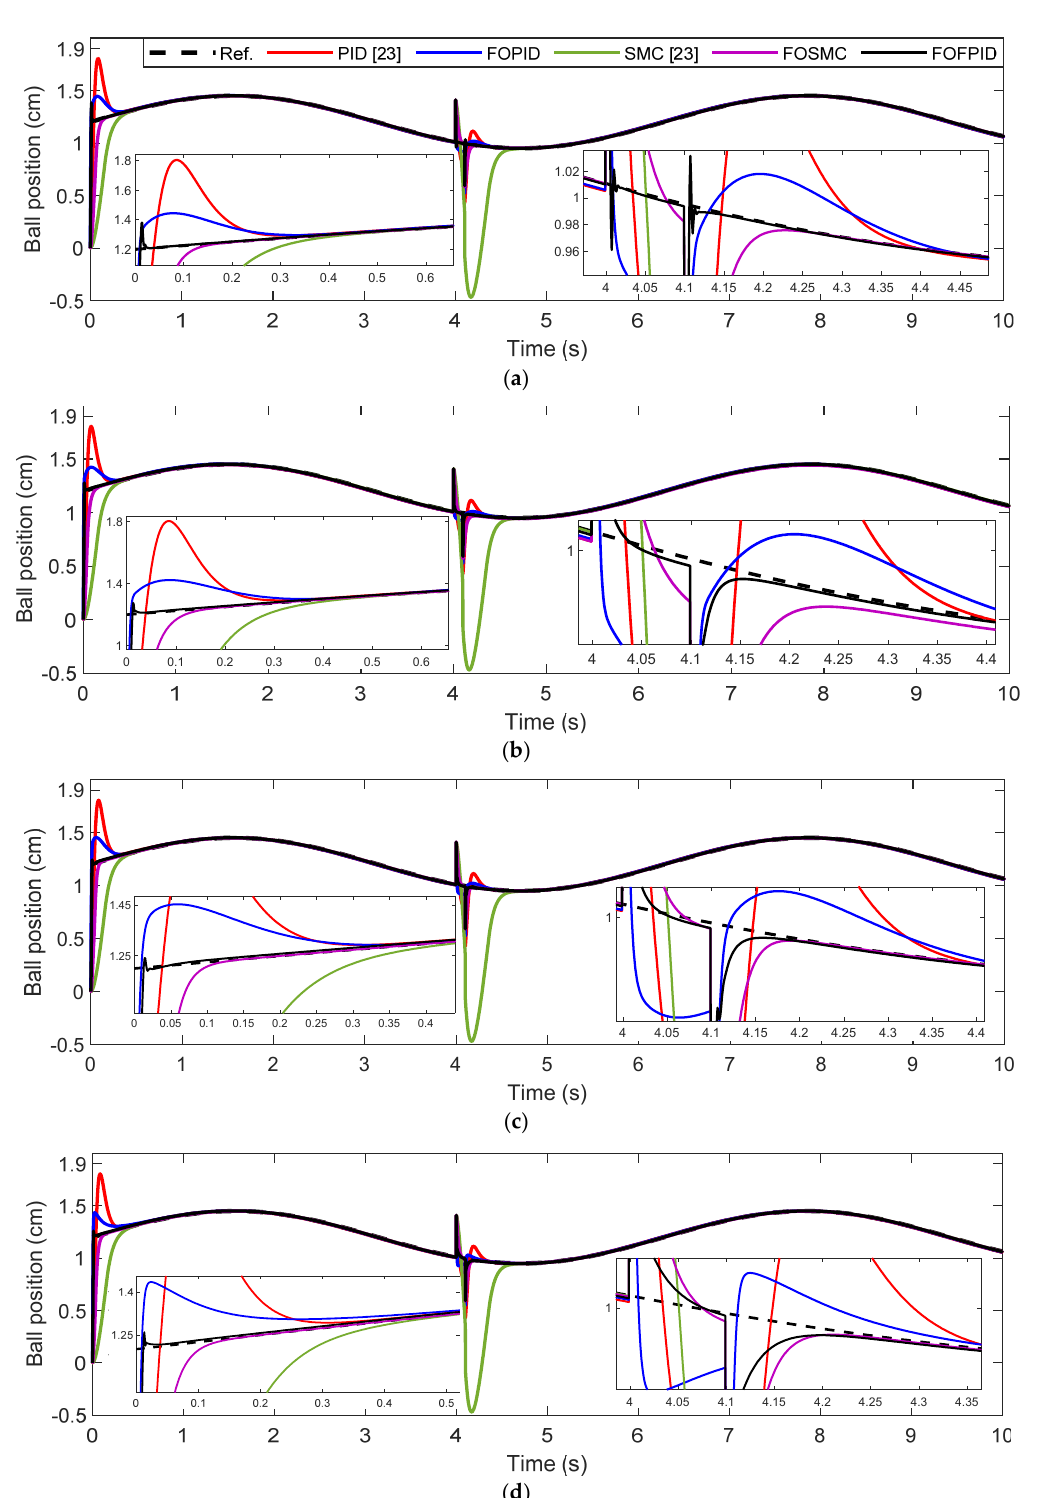
Figure 13. Comparison of the trajectory tracking performance of the Maglev system under different controllers based on J IAE ( a ), J ISE ( b ), J ITAE ( c ), and J ITSE ( d ) in presence of the